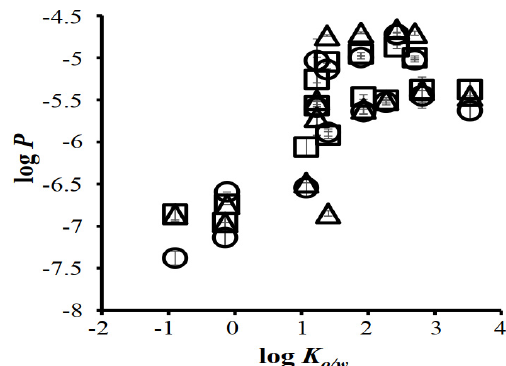
Figure 5. Relationships between the log Ko / w and log P of applied chemical compounds. Symbols: excised human skin ( △ ), excised hairless rat skin ( ○ ), and Strat-M™ ( □ ). All results are expressed as the mean ± S.E. (n = 3). P : permeability coefficient. Reproduced with permission from Uchida et al. [103] .